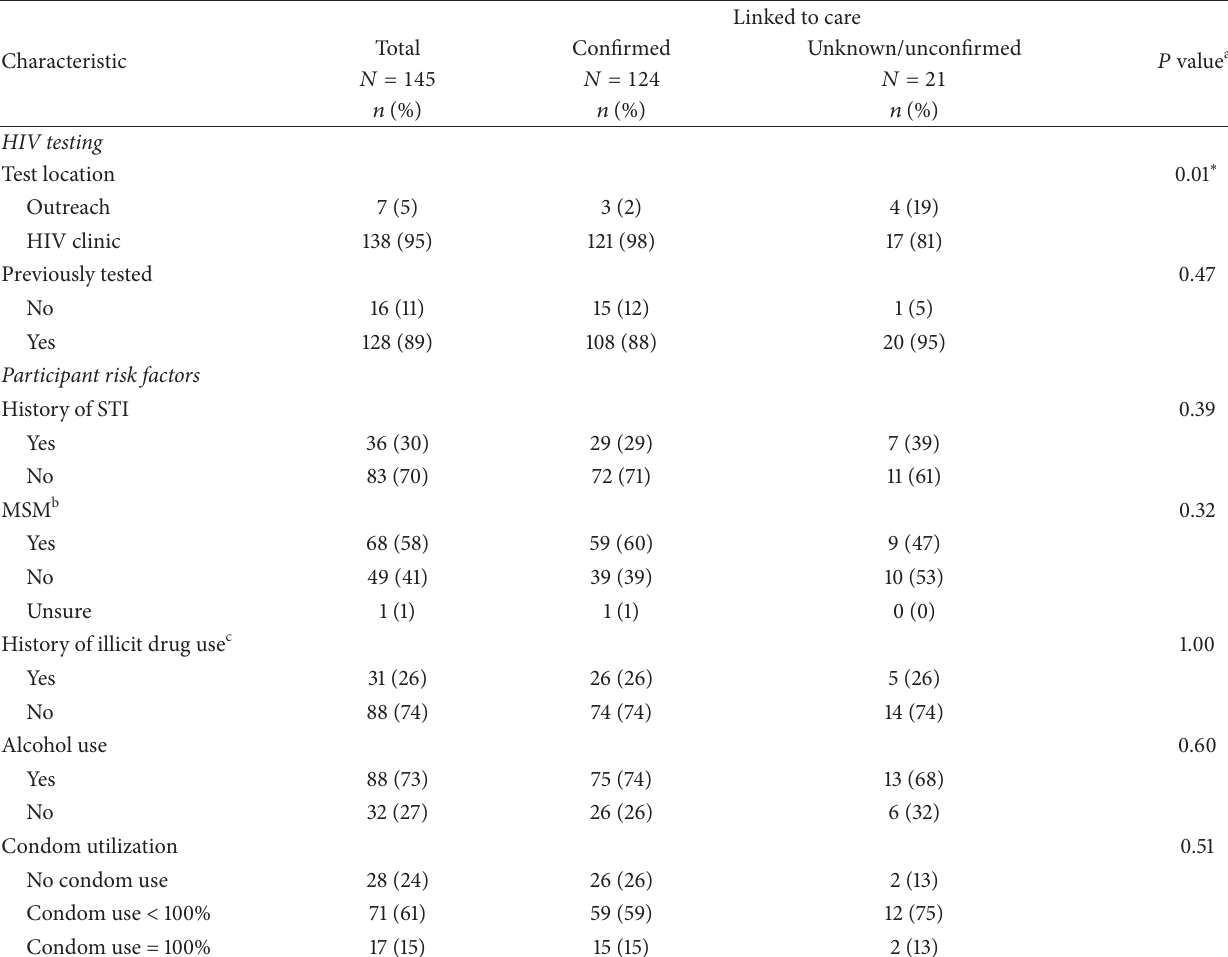
Table 6: Reported characteristics of clients who presented for HIV POC testing by linkage, AL, 2007–2012.